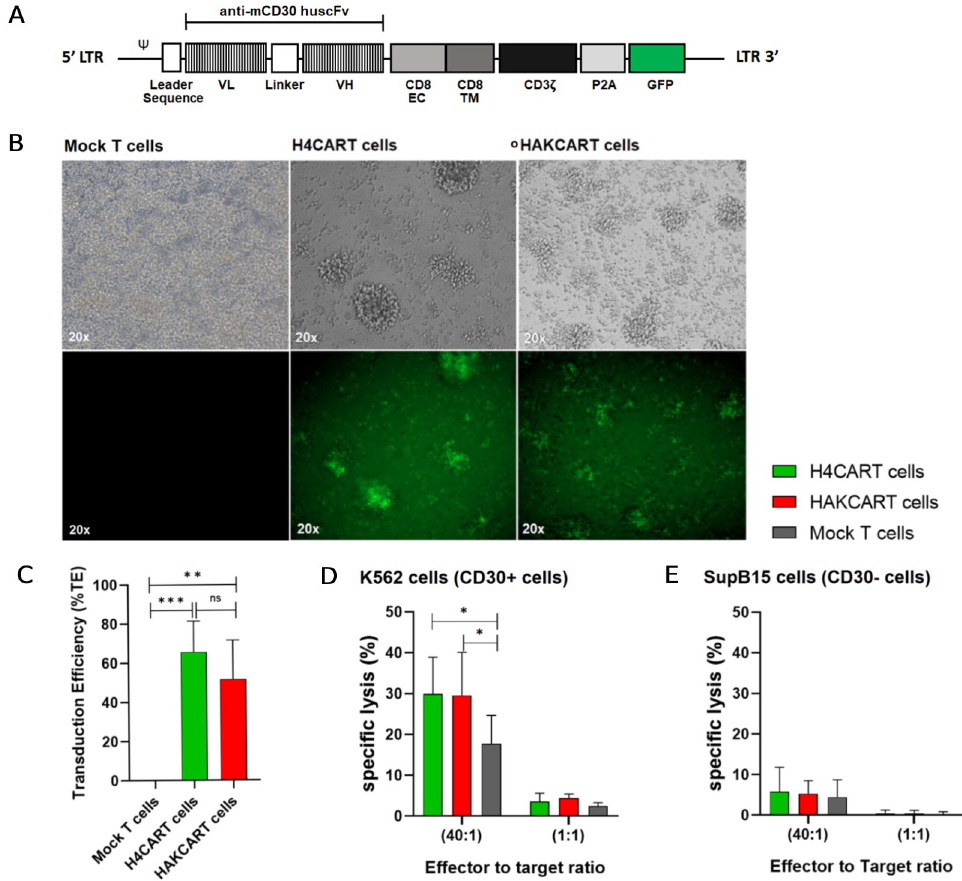
Fig 4. Transduction, characteristic, and cytotoxic assays of anti-mCD30 CAR T cells. (A) Schematic representation of the anti-mCD30 scFv -CAR lentiviral vector. (B) GFP of transduced T cells with scFv #A4-CAR lentivirus, H4CART, and scFv #AK-CAR lentivirus; HAKCART was observed under an inverted microscope at 20x; bright field (upper panel) and fluorescent field (lower panel). (C) The transduction efficiencies (%TE) of engineered T cells were significantly different from mock T cells (p = 0.0004 and p = 0.002, n = 4, one-way ANOVA (Tukey’s multiple comparisons test)), but there was no significant difference between both populations of engineered T cells (p = 0.4089, one-way ANOVA (Tukey’s multiple comparisons test)). (D) At an E:T ratio of 40:1, the cytotoxicity of H4CART and HAKCART cells on K562 cells was significantly higher than mock T cells (p = 0.0378 and p = 0.0439, respectively; n = 4, two-way ANOVA (Tukey’s multiple comparisons test)). (E) In SupB15 cells, the specific lysis of the engineered T cells was not significantly different from mock T cells at all E:T